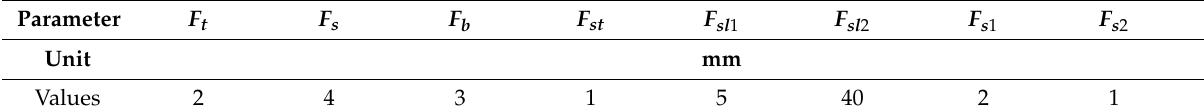
Table 2. Structural parameters of heat sink.